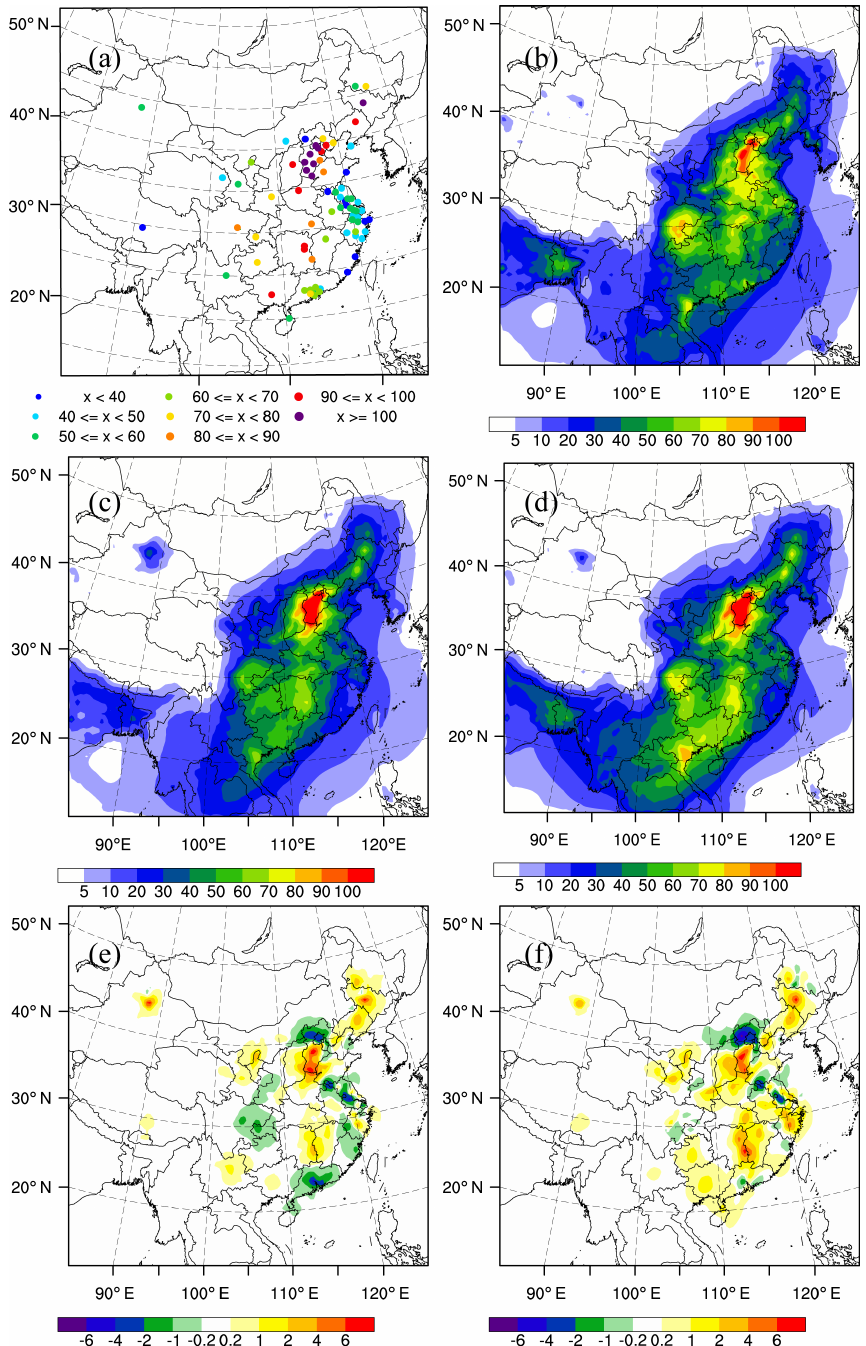
Figure 4. Spatial distribution of the PM 2 . 5 mass (µgm − 3 ) of the (a) observations, (b) simulation of the control run, (c) analysis of expJ, (d) analysis of expC, (e) increments of expJ and (f) increments of expC at the lowest model level averaged over all hours from 6 to 16 Octo- ber